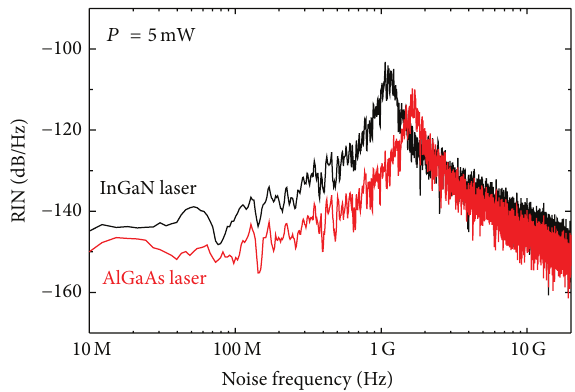
Figure 5: The spectra of RIN of InGaN and AlGaAs lasers when 𝑃 = 5 mW.